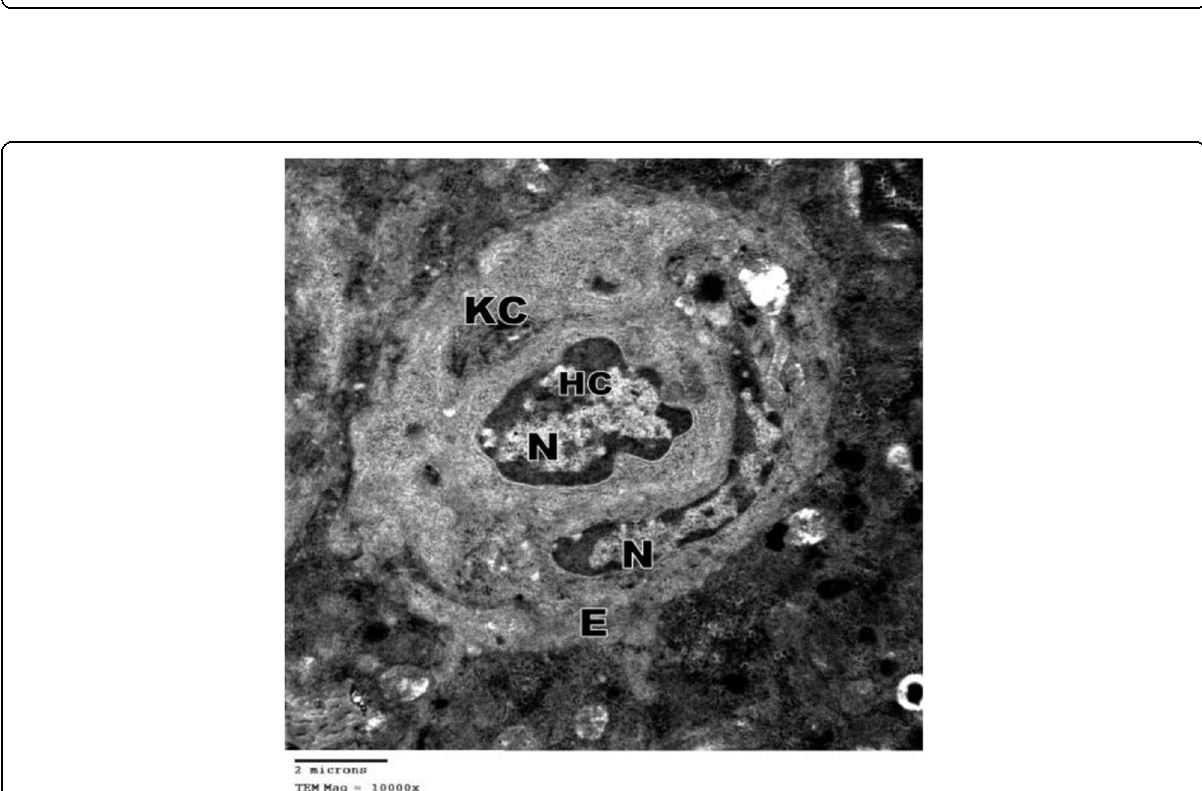
Fig. 22 An electron micrograph of a hepatocyte of treated mouse with Adamine (20 mg/kg b.wt.) for 10 days illustrating pyknotic nucleus (N) of Kupffer cell (KC) and endothelial cell (E) with elongated nucleus (N) with heterochromatin (HC) attached to inner membrane of nuclear envelope. (×